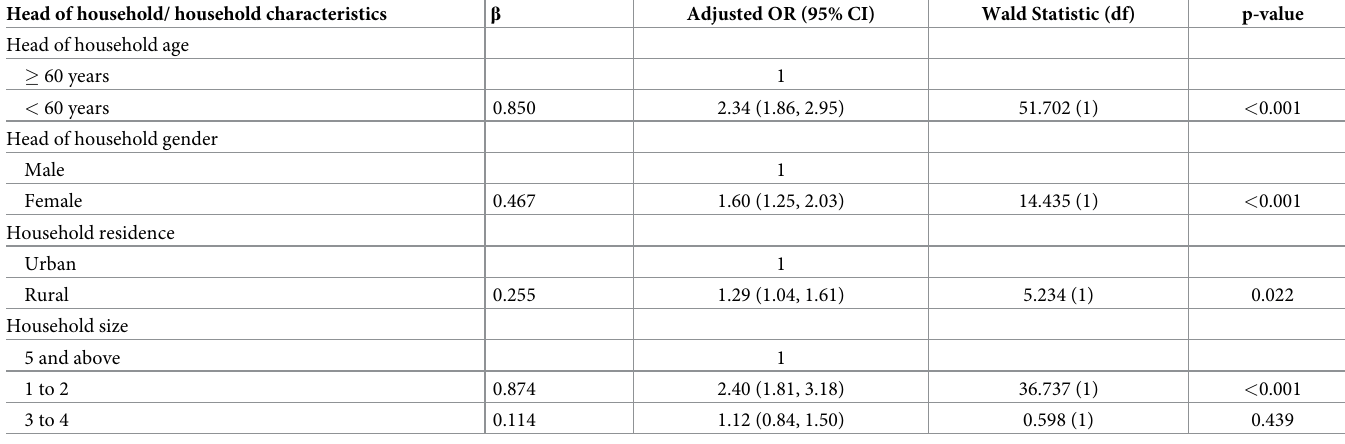
Table 2. Association between socio-demographic characteristics of households and CHE using multiple logistic regression (n = 13015). Head of household/ household